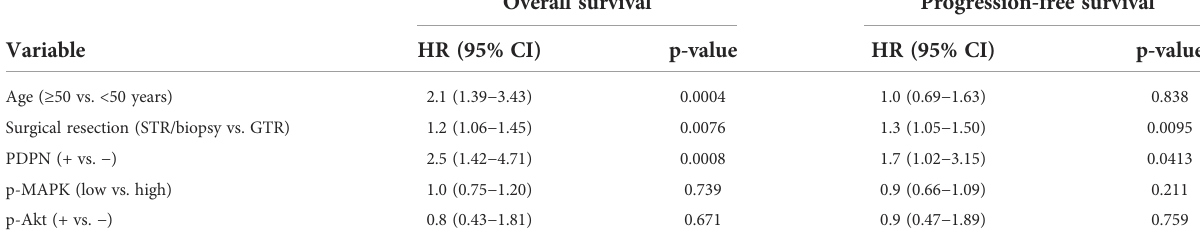
TABLE 2 Cox multivariate survival analysis for GBM